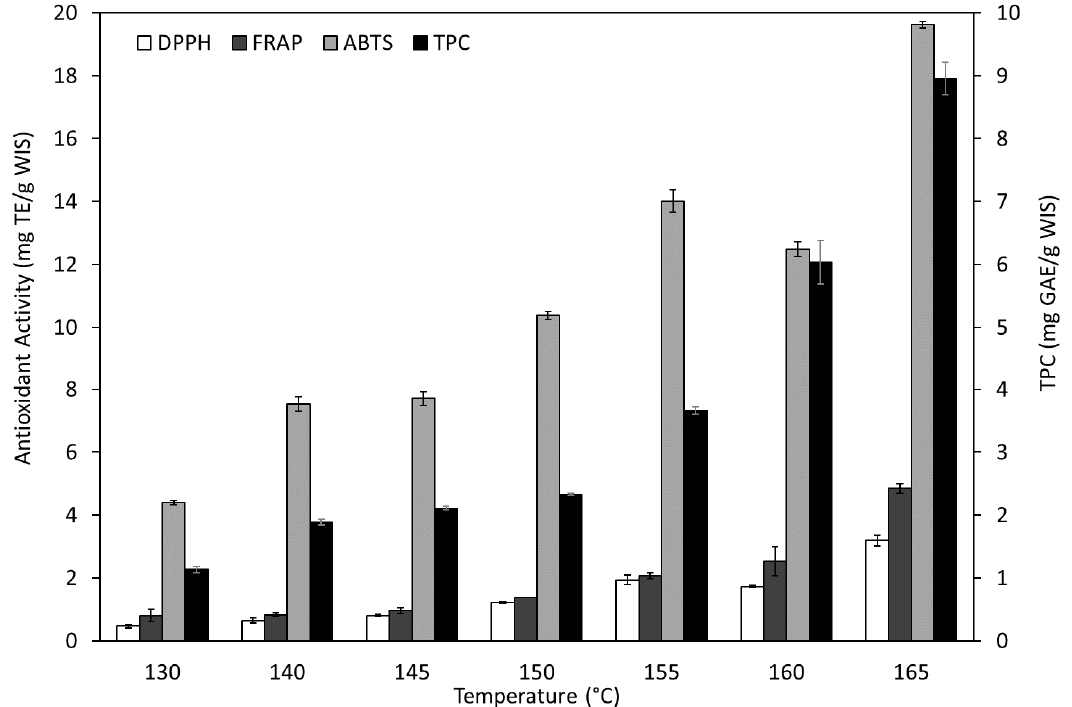
Figure 4. Effects of the autohydrolysis temperature on the total phenolic content (TPC) and antioxidant capacity of the extracted liquors by DPPH ( α , α -diphenyl- β -picrylhydrazyl), ABTS (2,2-azino-bis-3-ethylbenzothiazoline-6-sulphonic acid) and FRAP (ferric reducing antioxidant power) assays.